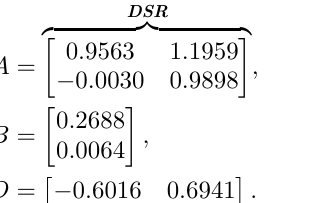
Figure 6: Example 4.3. The figure illustrates the closed loop system with an anti-slugging case ex- ample implemented in the K-Spice/Ledaflow simulator (K-Spice; LedaFlow). Output, y := Bottom hole riser pressure, [bara]. In- put, u := Topside choke valve, [%].